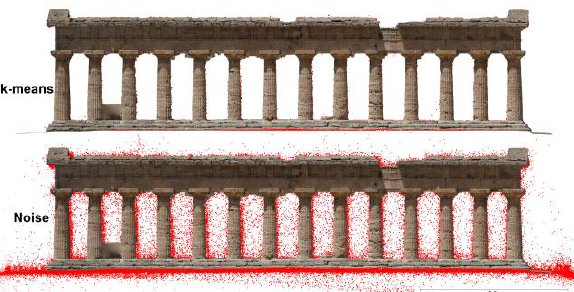
Figure 10. Cluster analysis and filtering by k-means: on top high accuracy cluster, on bottom for noise cluster.